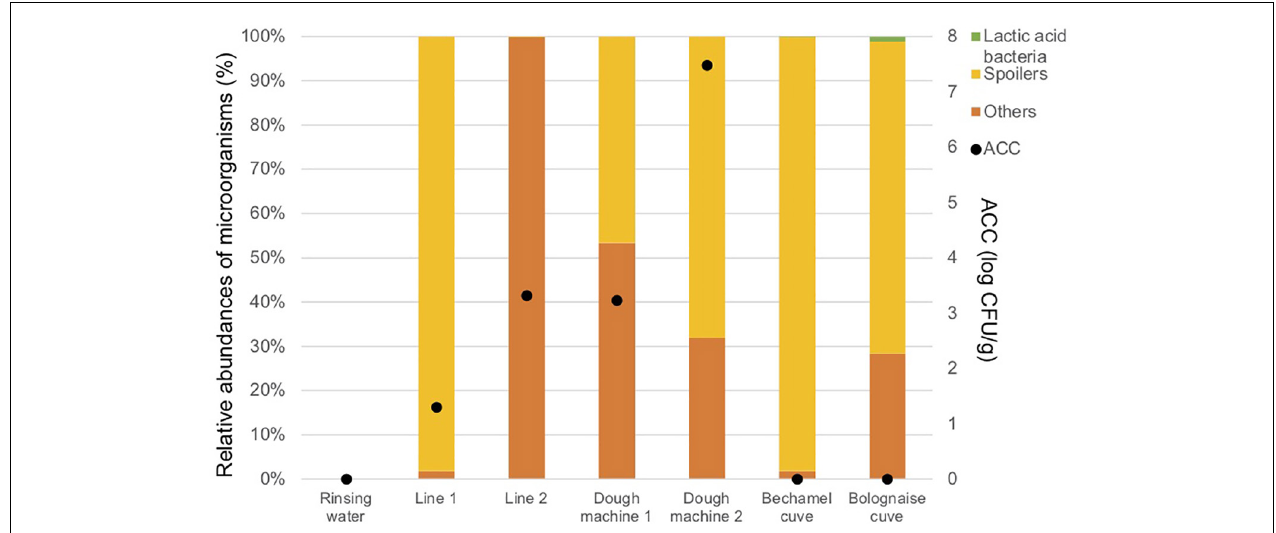
FIGURE 4 | Aerobic Colony Counts (ACC) (log CFU/ml) and abundances of the dominant bacterial groups (%) in the closed circuits during the reinforced enzymatic